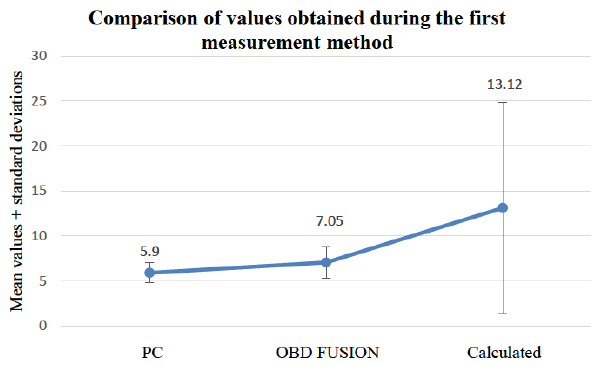
Figure 2: Comparison of values obtained during the first measure- ment method